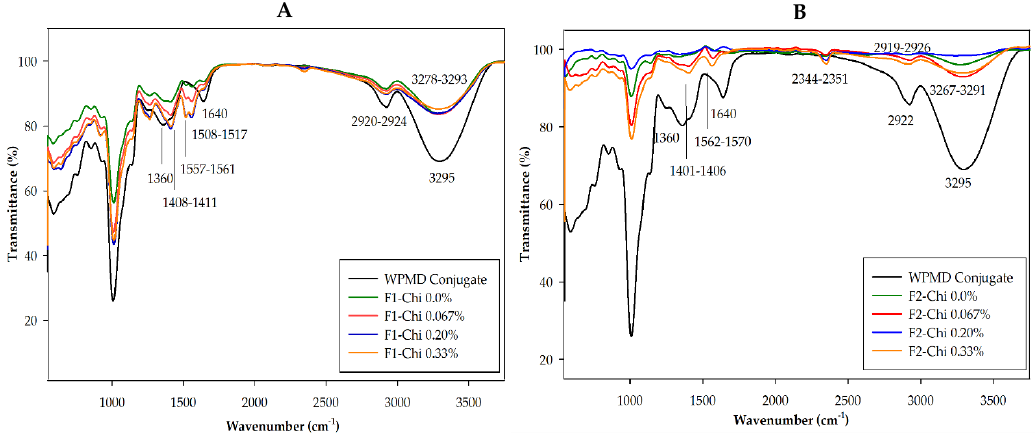
Figure 2. Infrared spectra of F1 ( A ) and F2 ( B ) spray-dried powders.